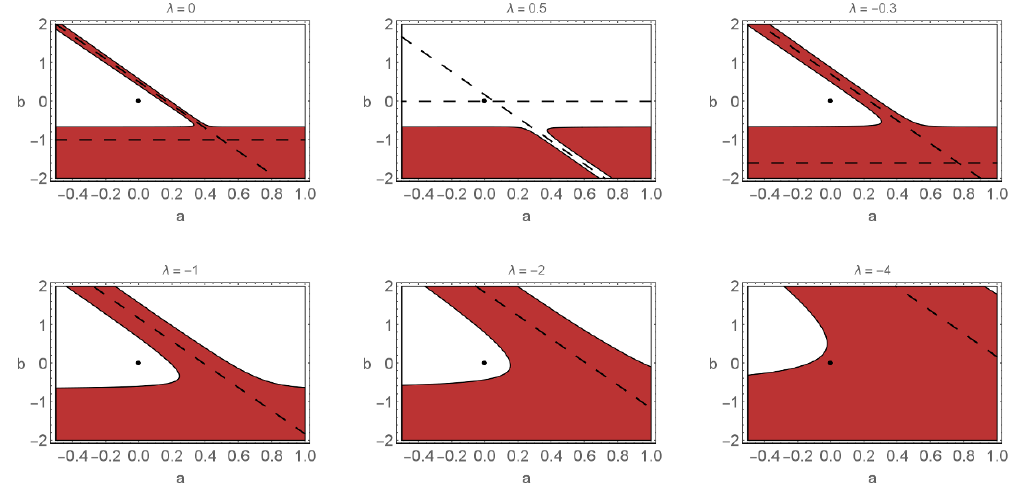
Figure 11 . Viable region (in red) for a quantum-gravity induced (cid:12)xed point for the Yukawa coupling for several values of the dimensionless cosmological constant within the standard ASQG framework. The dashed lines indicate the poles 1 + b (cid:0) 2 (cid:21) (TT-mode) and 1 (cid:0) 6 a (cid:0) 2 b (cid:0) 4 (trace